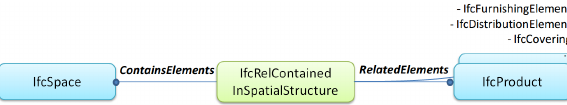
Figure 6: Relationships between IfcSpace and the elements con- tained in it.